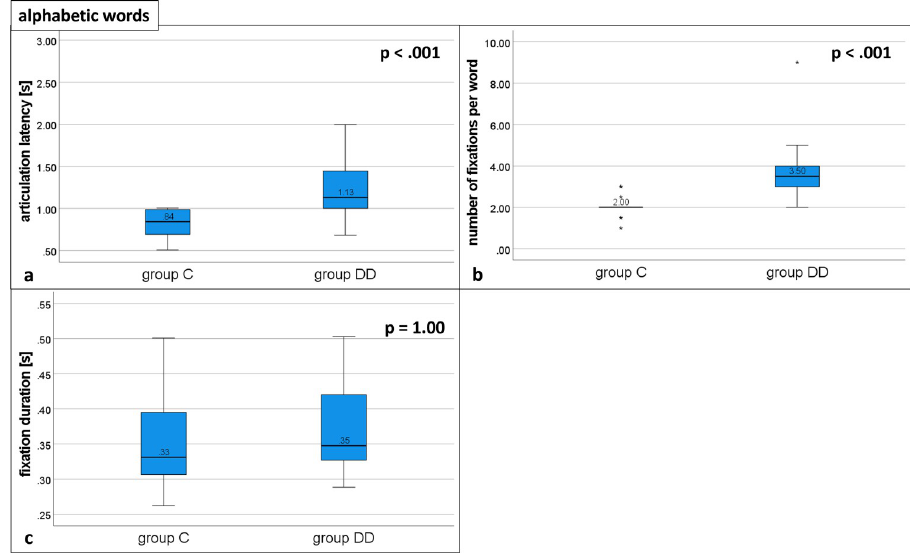
Fig 3. Eye movement variables during reading alphabetic words. Distribution of group DD and group C. Medians of a) articulation latency, b) number of fixations, and c) fixation duration; p = probability value. Statistically significant differences for a) and b). For details see Table